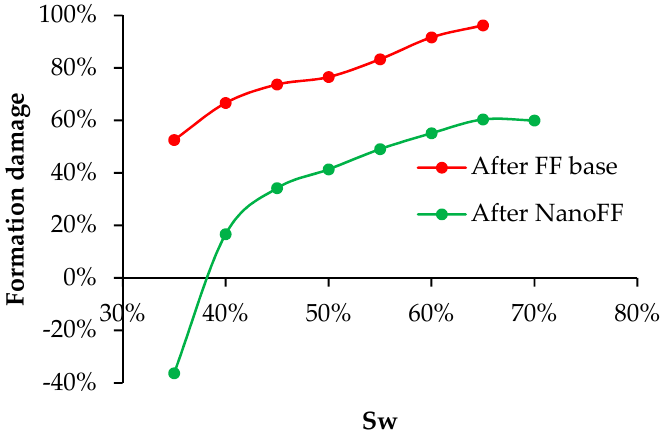
Figure 13. Formation damage behavior at different water saturations for the test carried out with the original and optimized NanoFF in the proppant porous media.